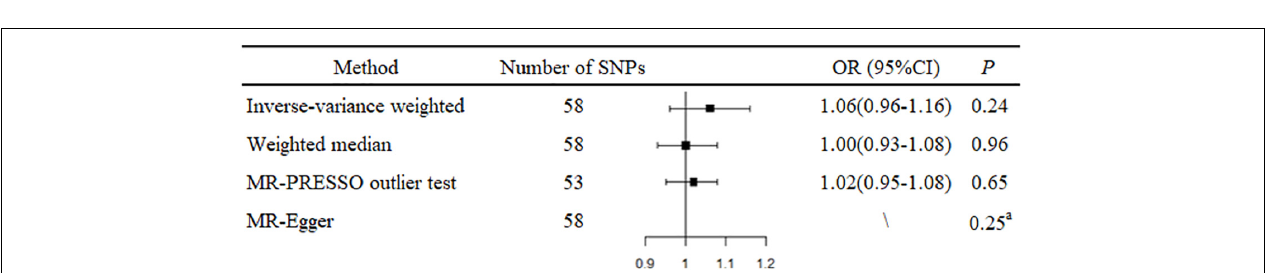
FIGURE 2 | Forest plot of Mendelian randomization analysis for the associations of circulating C-reactive protein levels with risk of prostate cancer. MR, Mendelian randomization; MR-PRESSO test, MR Pleiotropy RESidual Sum and Outlier test; OR, odds ratio; and SNP, single-nucleotide polymorphism. a P value of the intercept from MR-Egger regression